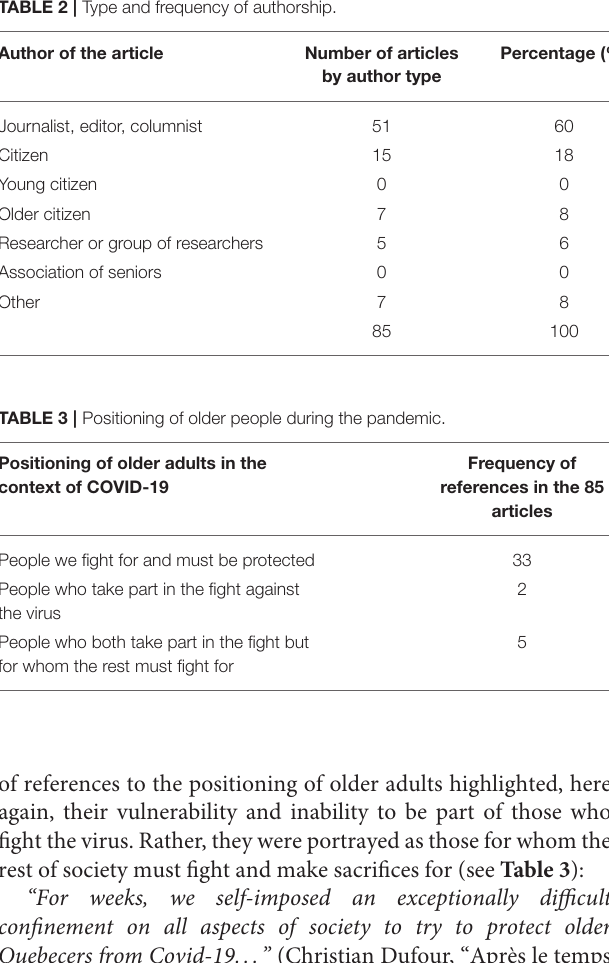
TABLE 2 | Type and frequency of authorship.